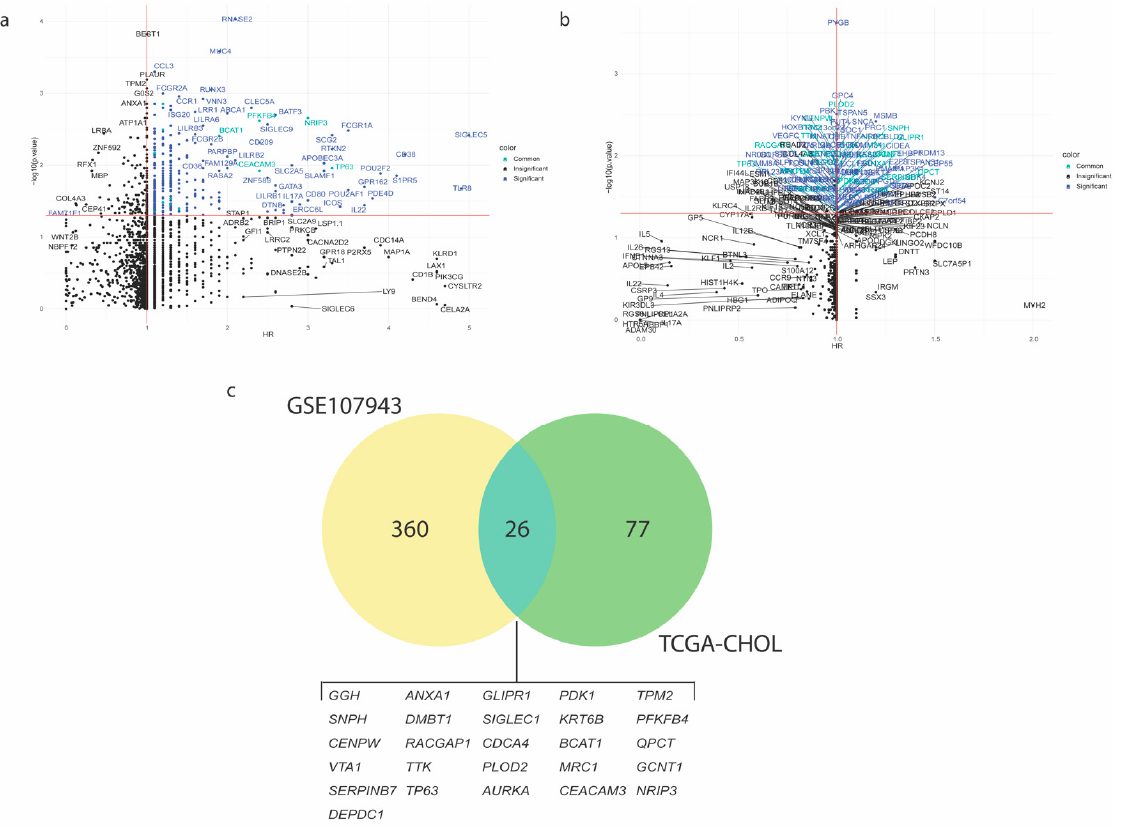
Figure 2. Identification of the mortality-associated immune-related genes for cholangiocarcinoma (CCA). The scatter plots show Cox-Proportional Hazard Ratio (HR; x-axis) and − log10 ( p -value) (y-axis) of 3017 immune-related genes in CCA tumor transcriptomic profiles from ( a ) GSE107943 ( n = 30 samples) and ( b ) TCGA-CHOL ( n = 36 samples) cohorts. The candidate gene was considered valid if HR > 1 and p -value < 0.05. ( c ) Venn diagram shows 26 mortality-associated immune-related genes that commonly presented between two cohorts.